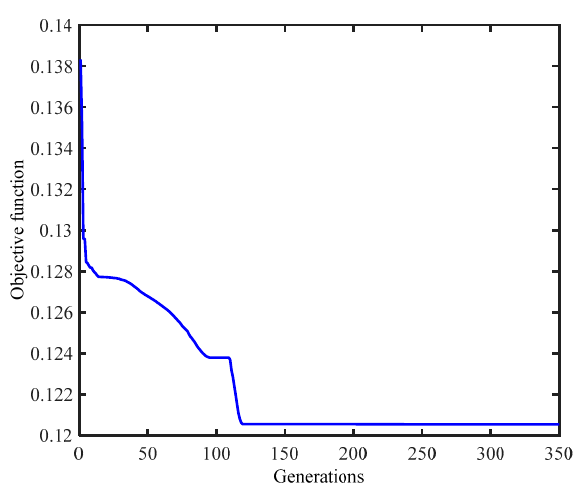
Figure 6. Convergence of the objective function.